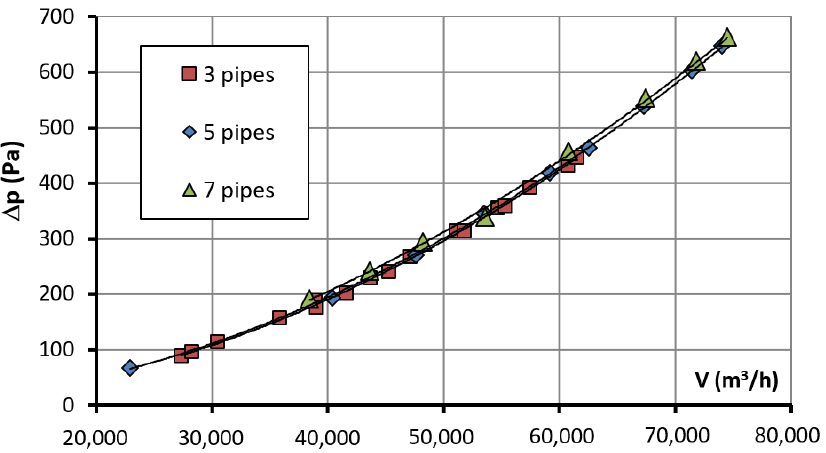
Figure 6. Flow characteristic: total pressure losses ∆ p as a function of total airflow V ; the result of the experimental investigation for exchanger model: 3, 5 or 7 pipes, L = 76 d , d = PP DN50, d main = PP DN50.